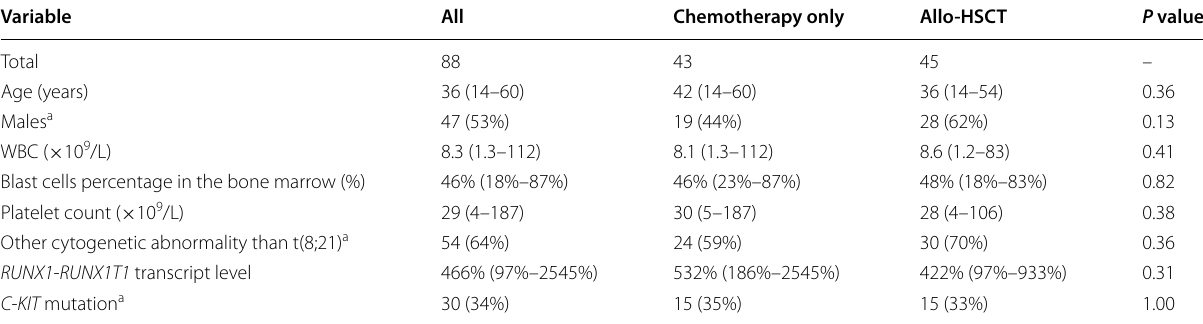
Table 2 Variables at diagnosis of AML patients with t(8;21) who achieved complete remission and received chemother- apy only and